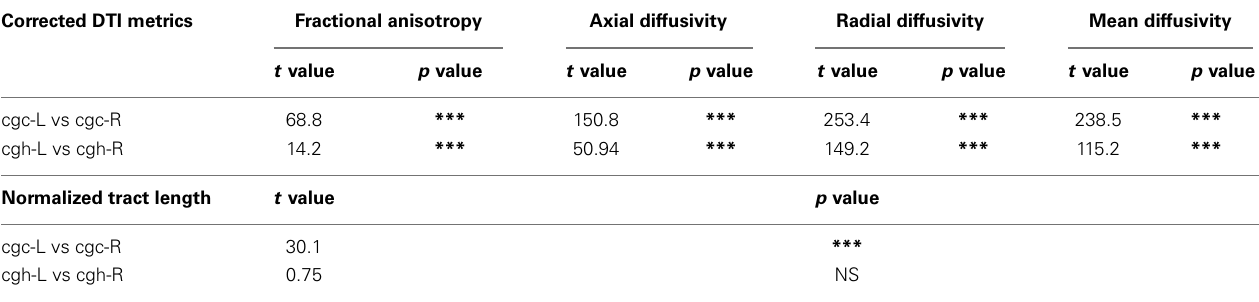
Table 7 | Comparisons of normalized tract length and corrected DTI metrics between the left and right cingulate gyrus part of cingulum (cgc) and between the left and right hippocampal part of cingulum (cgh), with age and gender as covariates . Corrected DTI